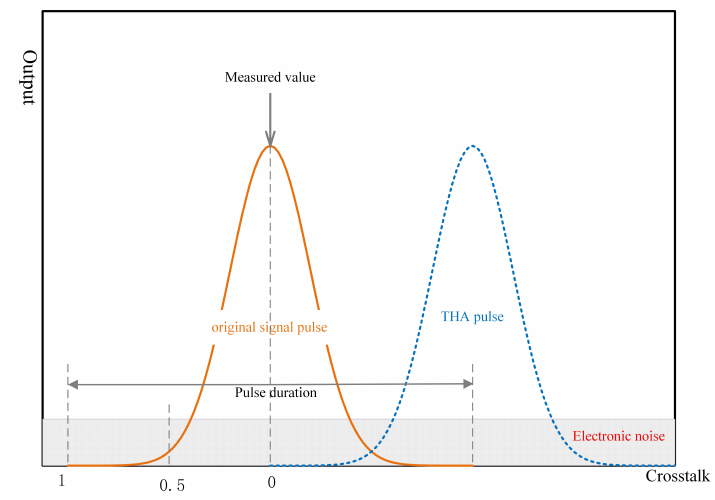
Figure 3. Schematic diagram of time-domain waveforms of Trojan horse pulse and original pulse. The solid red line represents the original pulse, and the dashed blue line represents the Trojan horse pulse. THA: Trojan horse